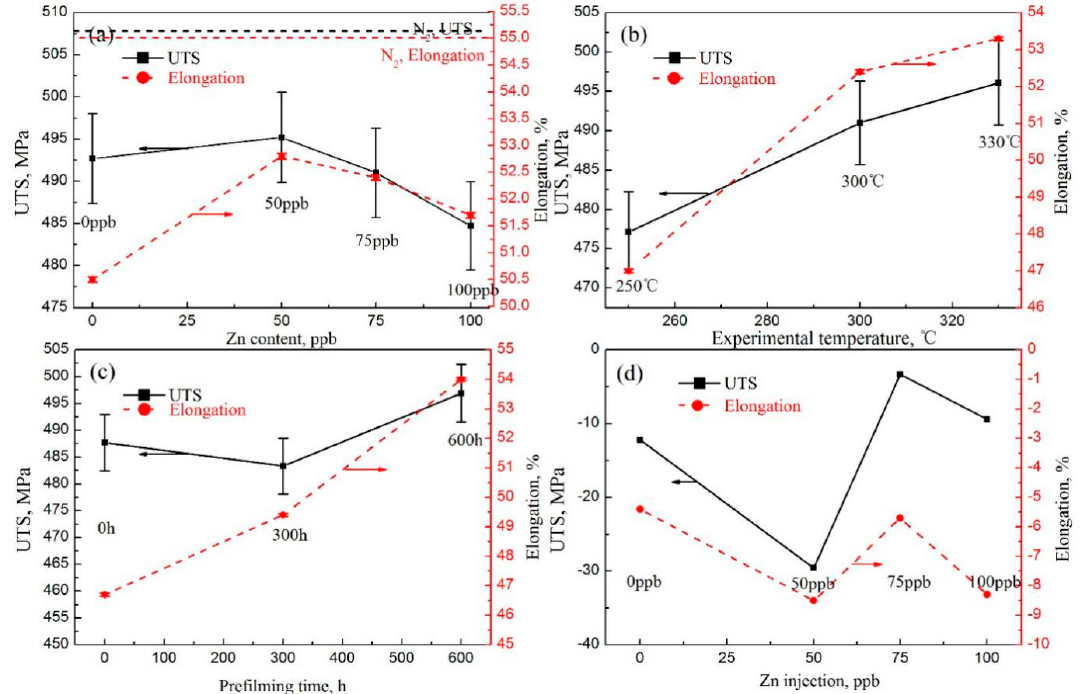
Figure 3. ( a ) Tensile properties vs. Zn content in the chemical solution; ( b ) tensile properties vs. experimental temperature; ( c ) tensile properties vs. prefilming time; and ( d ) reduced values of tensile properties when the strain rate decreases from 9.26 × 10 − 7 /s to 4.63 × 10 − 7 /s with different Zn content in chemical solution.